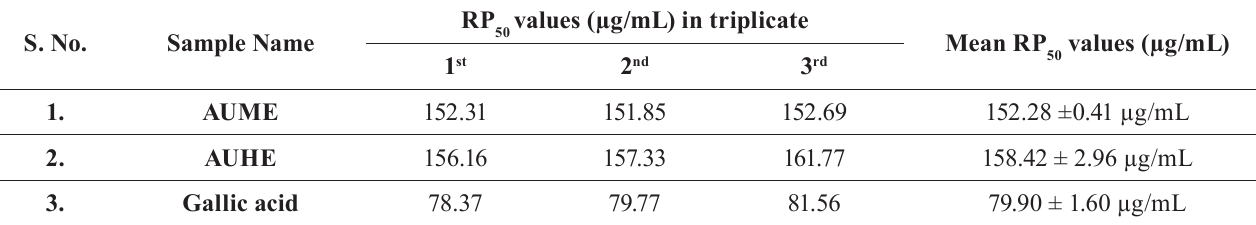
TABLE V - R P value of reducing power of plant extracts of whole plant of A. uliginosa 50